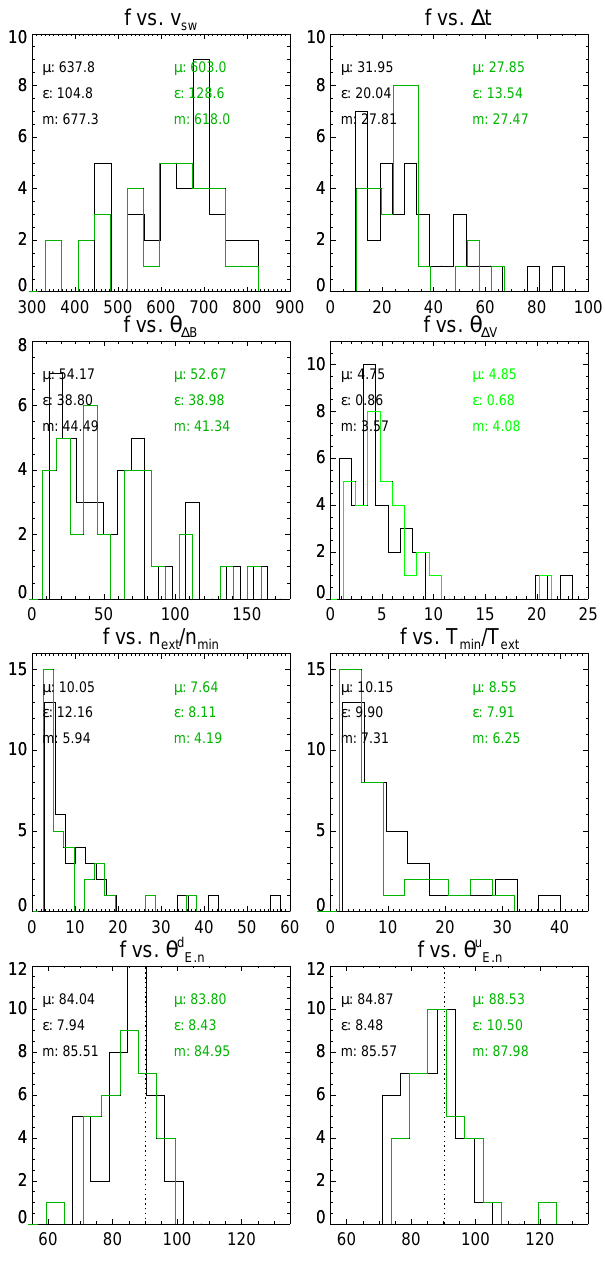
Fig. 11. Fig. 11. Frequency distributions: f vs. v f vs. θ 1v ; f vs. n ext / n min ; f vs. T min / T ext ; f vs. θ d C1 results are black; those for C3 are